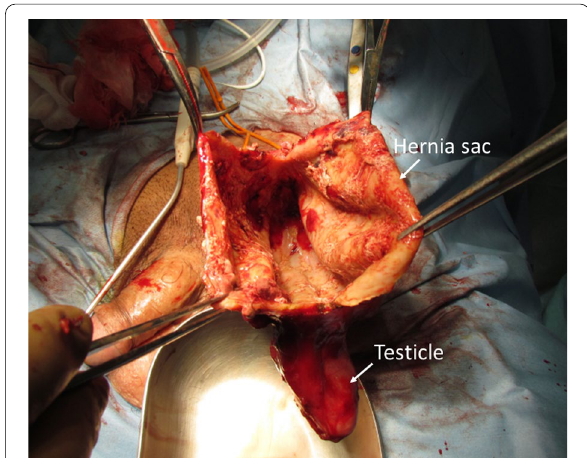
Fig. 5 Intraoperative findings during the second operation. The walls of the hematocele were